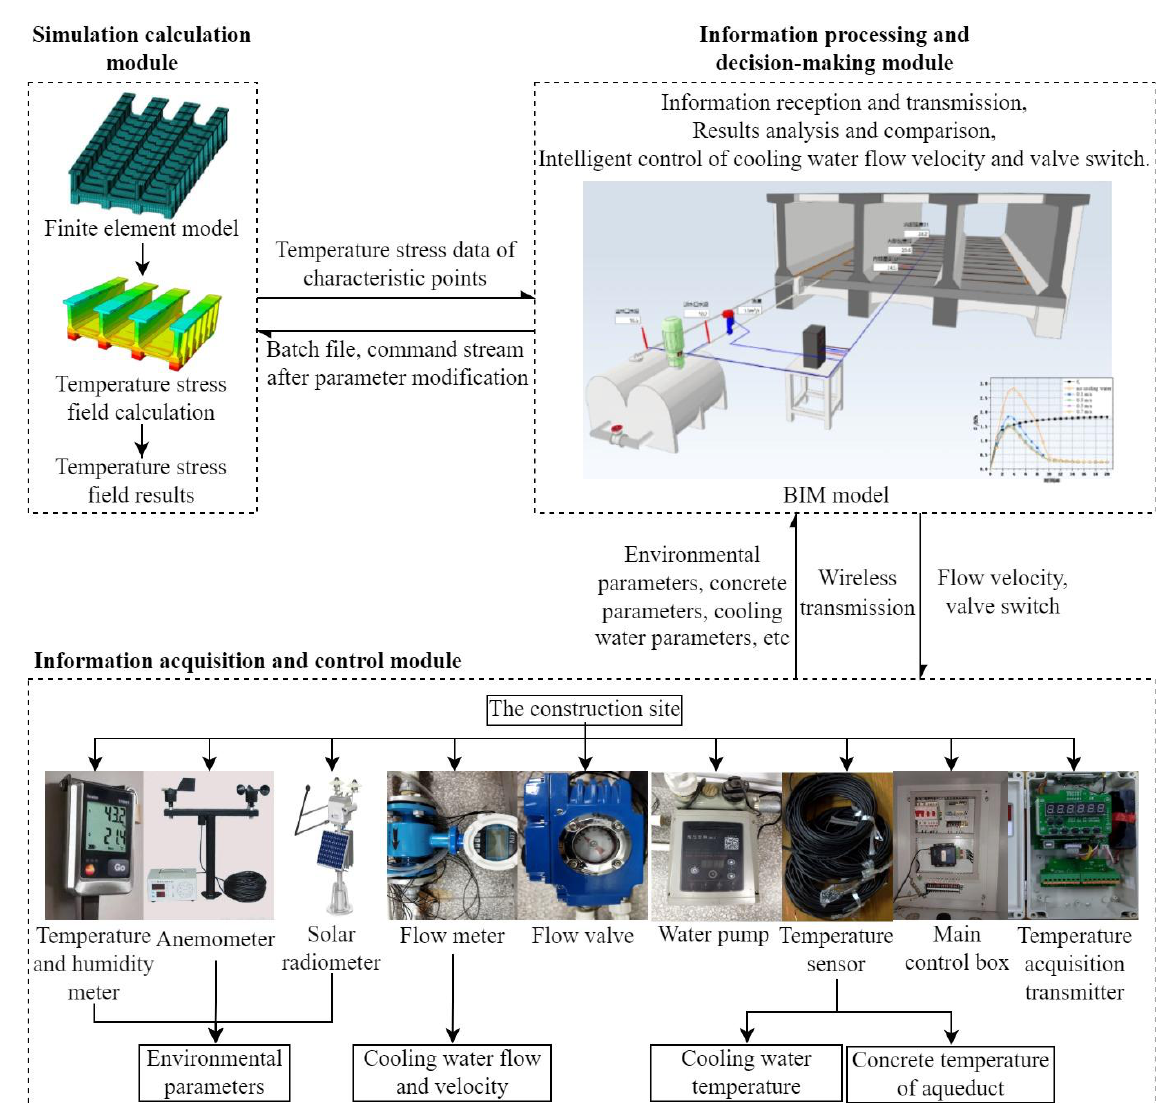
Figure 1. Sketch of intelligent temperature control system for a large aqueduct.